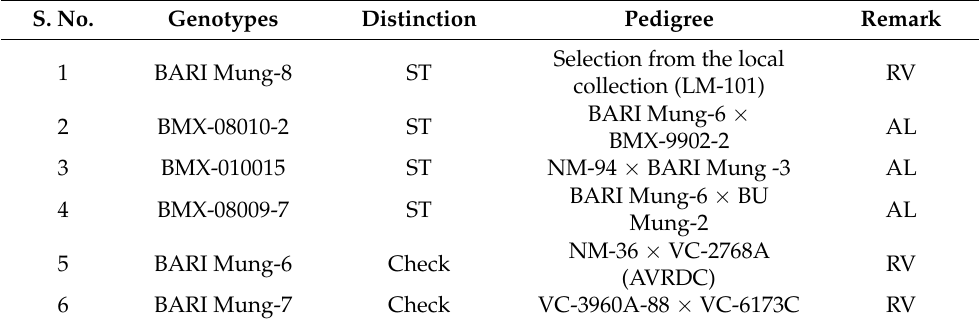
Table 1. Illustration of the experimental material used in the study. S.